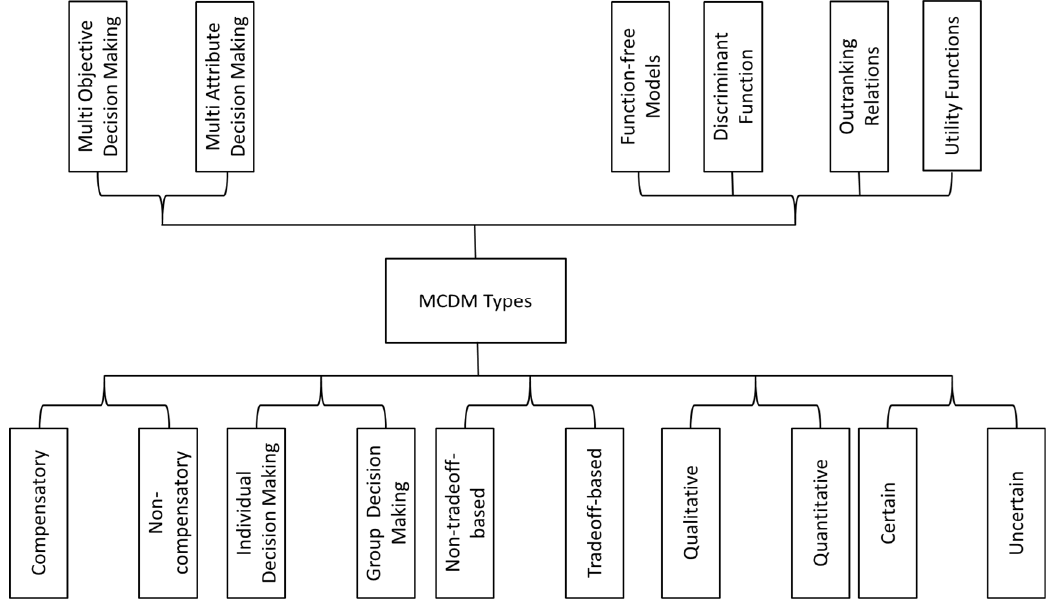
Figure 2. Different Classifications of MCDM.